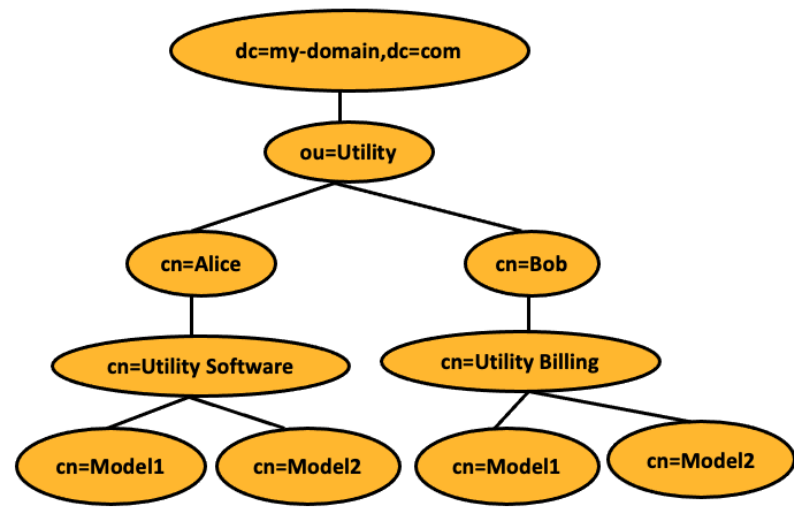
Figure 7. DIT Format Example of a DER